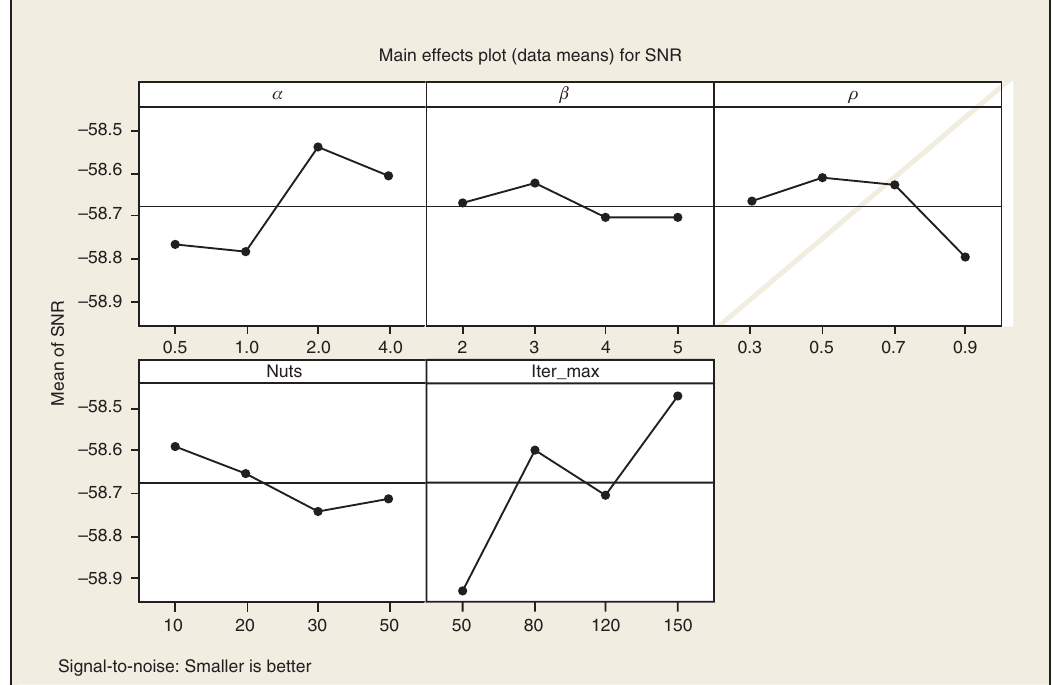
Figure 4: Mean of SNR.